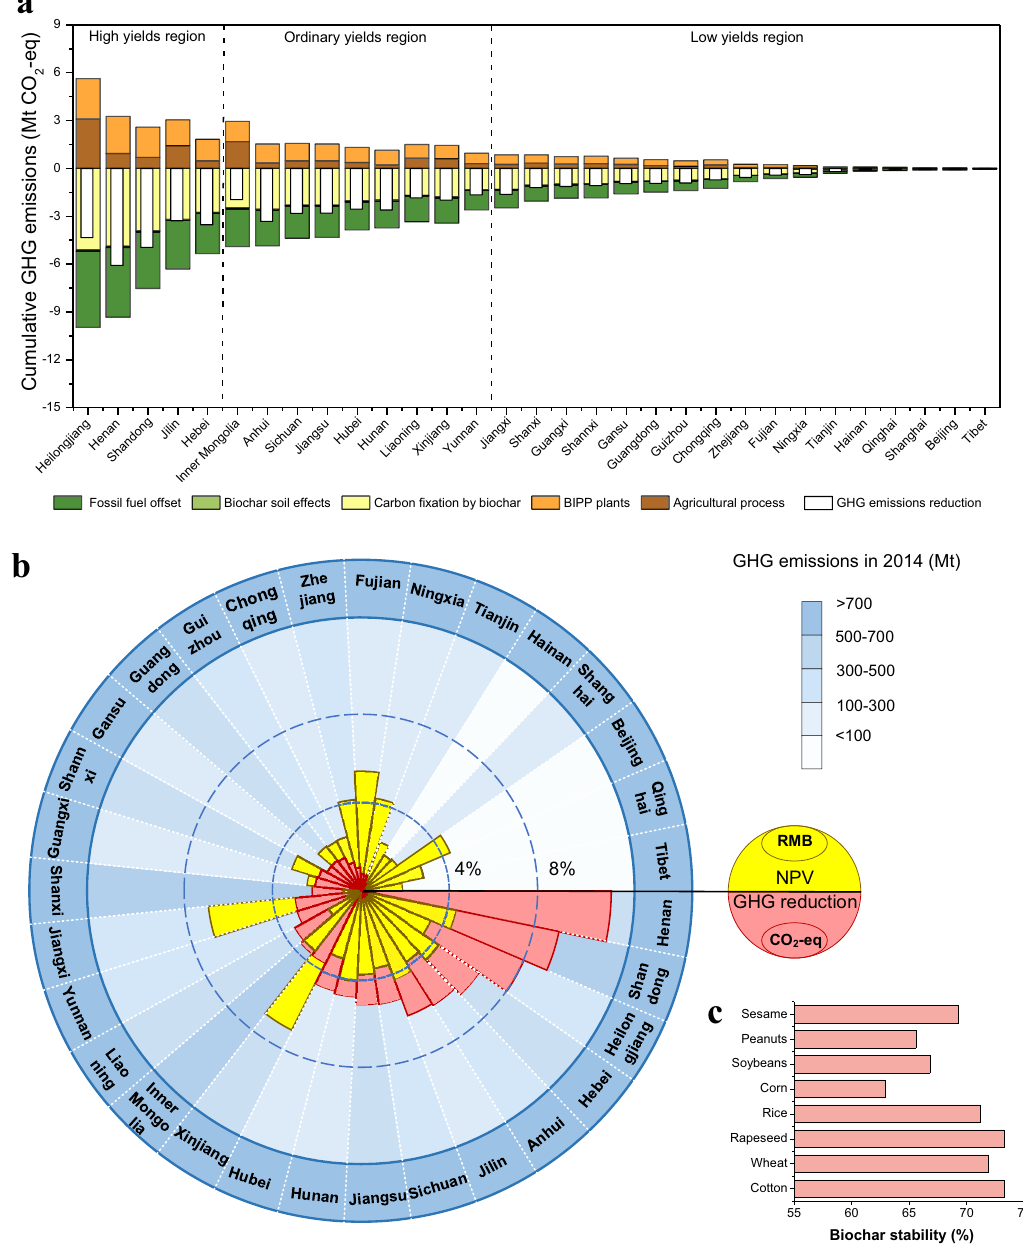
Fig. 4 Spatial distribution of GHG emissions reduction and economic feasibility of national deployment of BIPP systems. a Comparison of GHG emissions reductions across Chinese provinces with deployment of BIPP systems (note that provinces are ordered by the amount of available crop residues); b overlapping graph of shares (%) of national GHG emissions reduction per year (red sectors) that could be achieved in Chinese provinces using BIPP systems with biochar sequestration (omitting Taiwan, Macao, and Hong Kong), and shares (%) of national NPV economic performance (yellow sectors); the blue background shades indicate total GHG emissions levels in 2014 32 , as de fi ned at right; c the stability of biochar produced from various crop residues of a BIPP system at 600